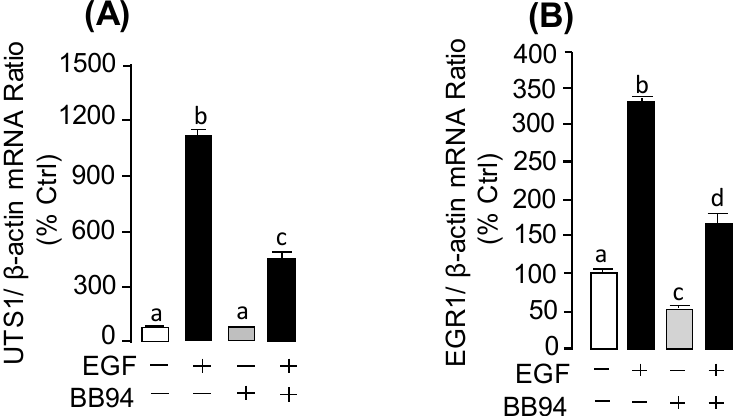
Figure 6. EGF induced TIMP3 mRNA expression and receptor specificity in grass carp pituitary. ( A ) Time course of EGF (0.5 μ M) treatment on TIMP3 mRNA expression. ( B ) Effect of EGF concentration (0.05–500 nM)-induced on TIMP3 mRNA expression in grass carp pituitary cells. ( C–E ) Effects of ErbB1 antagonist AG1478 (10 μ M), ErbB2 antagonist AG879 (10 μ M), and IGF receptor antagonist AG1024 (10 μ M) on TIMP3 mRNA expression for 24h, respectively. After drug treatment, total RNA was isolated for real-time PCR of MMP13 mRNA expression. In the data present (mean ± SEM), the di ff erences between groups were considered as significant at p < 0.05 (“*”) or highly significant at p < 0.01 (“**”). The groups denoted by di ff erent letters represent a significant di ff erence at p < 0.05.